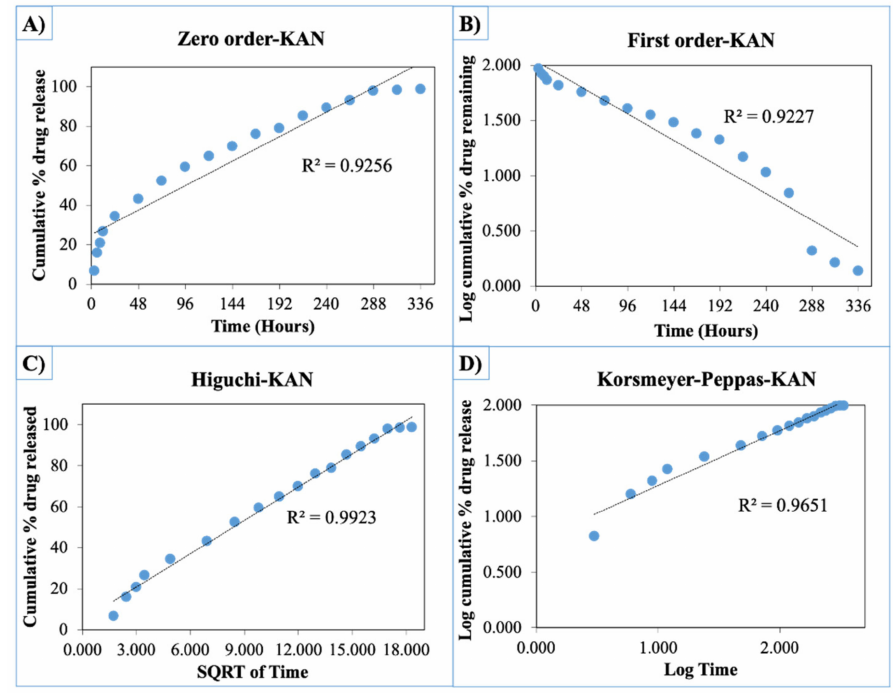
Figure 11. Zero order ( A ), first order ( B ), Higuchi ( C ), Korsmeyer–Peppas ( D ) kinetic releases of BC/PCL+KAN